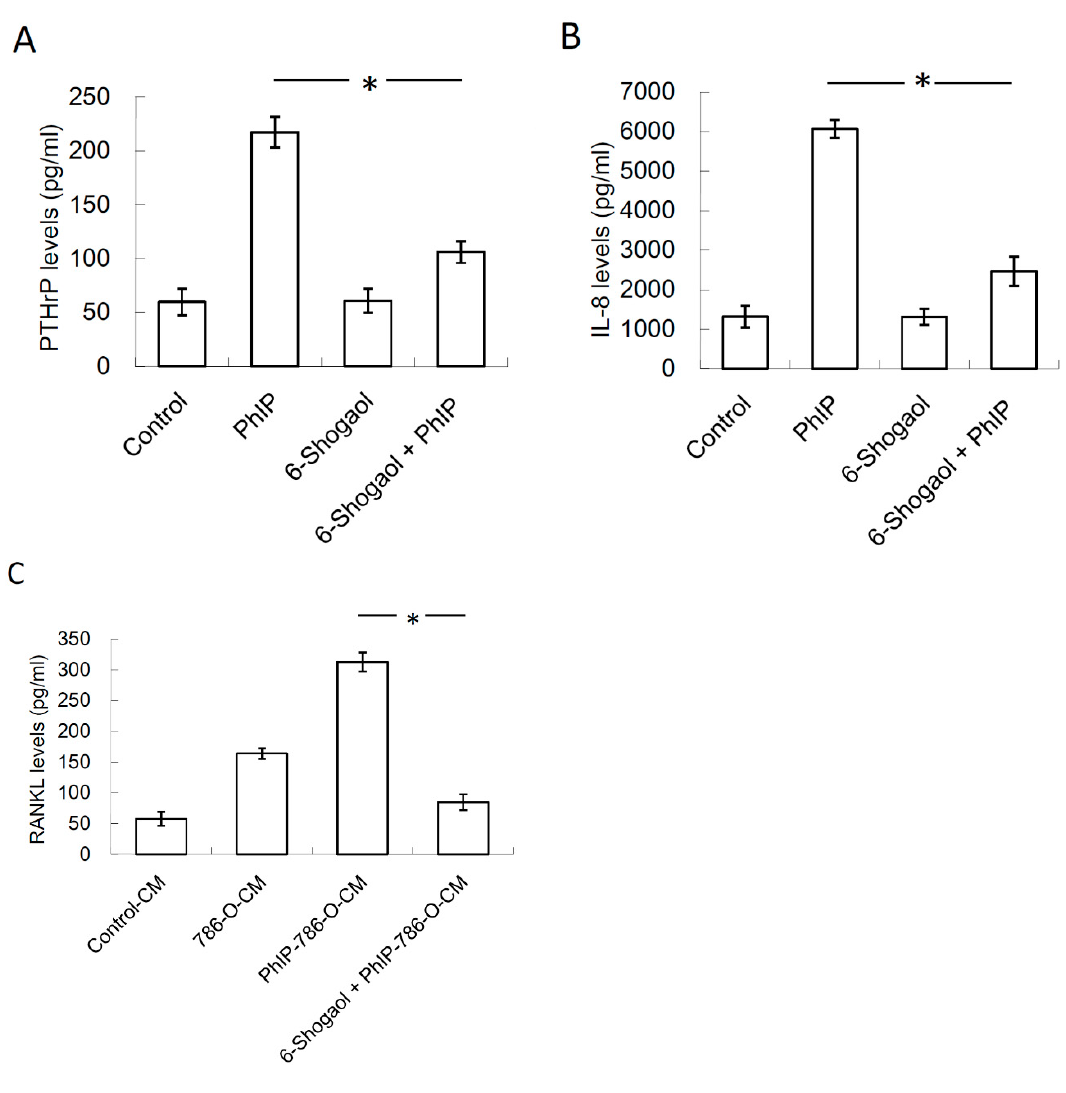
Figure 5. 6-Shogaol decreased the e ff ects of PhIP on PTHrP, IL-8, and RANKL expression. ( A ) The PTHrP levels in medium of 786-O. For assessing the level of PTHrP, 786-O cells were pre-treated with 6-shogaol for 1 h, and then with 20 µ M PhIP for 6 h. After replacing fresh medium and another 24 h culture, the PTHrP levels in medium of 786-O were measured. ( B ) The IL-8 levels in medium of 786-O cells. For assessing the level of PTHrP, 786-O cells were pre-treated with 6-shogaol for 1 h, and then with 20 µ M PhIP for 24 h. ( C ) The RANKL levels in medium of osteoclasts. For assessing RANKL, 786-O were pre-treated with 6-shogaol for 1 h, then incubated with 20 µ M PhIP for 6 h. After replacing fresh medium and another 24 h of culturing, the culture medium of 786-O was harvested and then added to osteoblasts for a 24 h culture. Each value is the mean ± SD of three independent experiments. * P < 0.05, or significant di ff erence between the control and test groups.